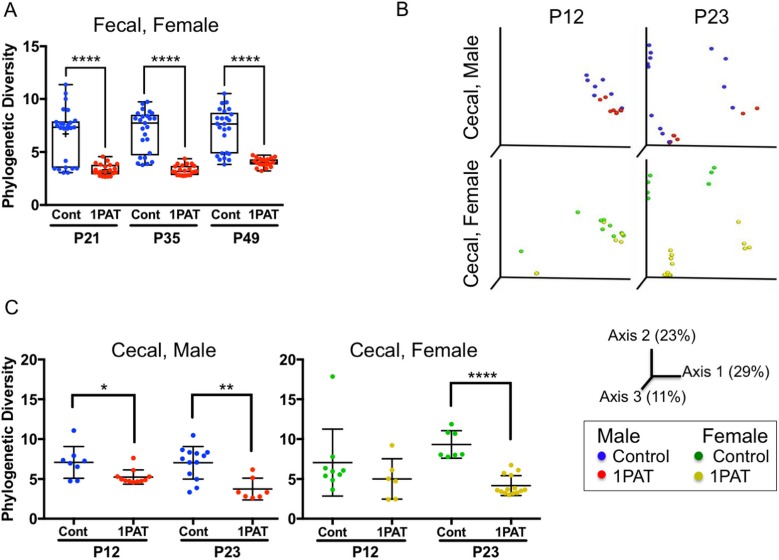
Fecal and cecal microbiota characteristics of 1PAT and control male and female NOD mice.(A) α-diversity (Phylogenic diversity (PD)) of fecal microbiota in females (P21, P35 and P49). Statistical significance determined by one-way-ANOVA test. ****p<0.0001. (B) β-diversity, as measured by unweighted UniFrac analysis of cecal microbiota over time (P12, and P23). (C) α-diversity (PD) of cecal microbiota in both males and females (P12 and P21). Statistical significance determined by one-way-ANOVA test. *p<0.05; **p<0.01; and ****p<0.0001.